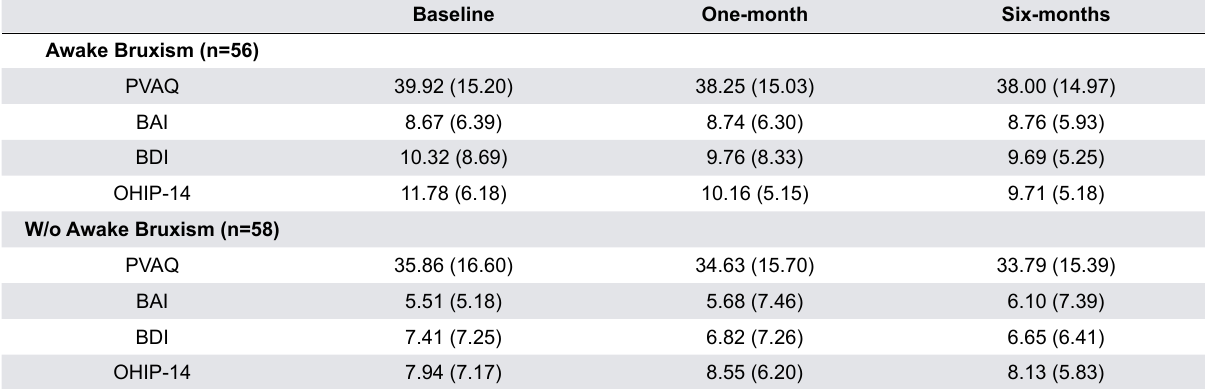
MACHADO NA, COSTA YM, QUEVEDO HM, STUGINSKI-BARBOSA J, VALLE CM, BONJARDIM LR, GARIB DG, CONTI Table 2- Mean and standard deviation (SD) of the pain vigilance and awareness questionnaire (PVAQ), beck anxiety inventory (BAI), beck depression inventory (BDI), and short-form of the oral health impact profile (OHIP-14) throughout the study follow-up (p=0.050)